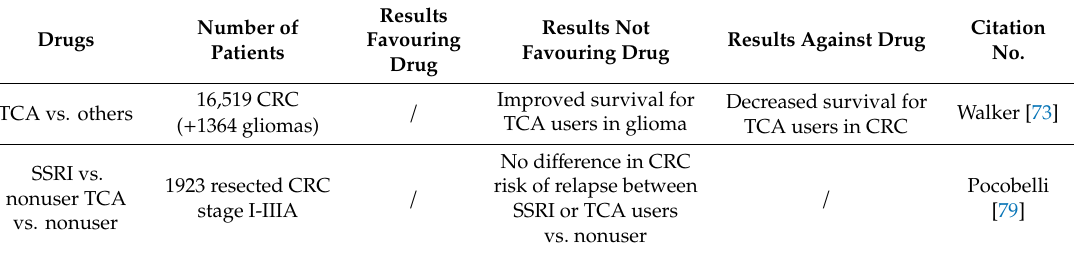
Table 3. Summary of studies for antidepressants as a prognostic